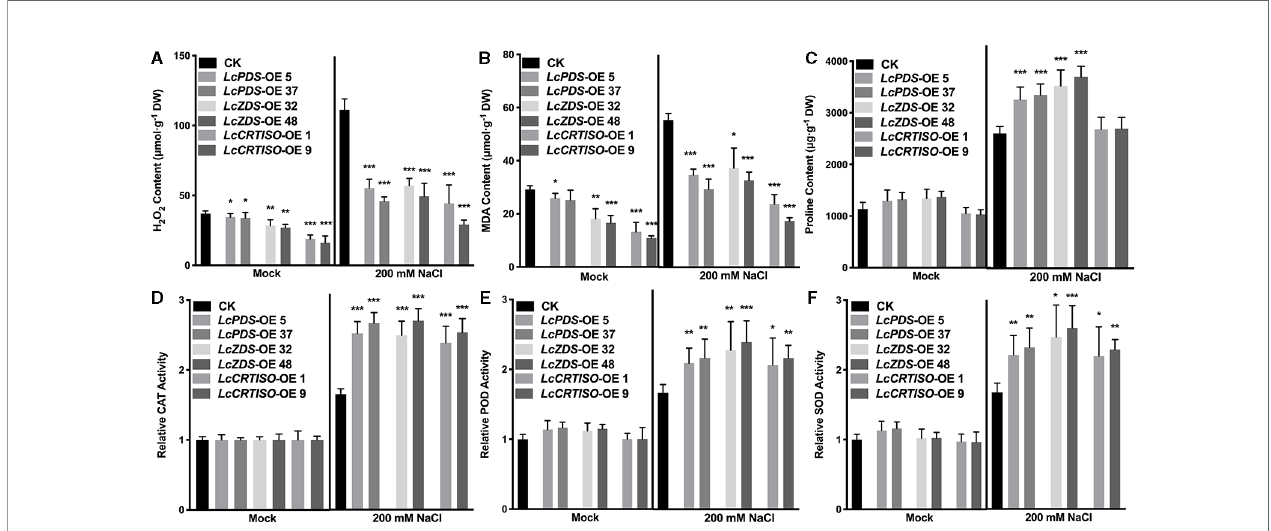
FIGURE 3 | Antioxidative components in LcPDS , LcZDS , and LcCRTISO over-expressing tobacco lines were analyzed. The contents of (A) H 2 O 2 , (B) malonaldehyde (MDA), and (C) proline were assayed, and activities of (D) catalase (CAT), (E) peroxidase (POD), and (F) superoxide dismutase (SOD) were analyzed. Data were obtained from three independent experiments and ANOVAs was performed. The results were presented as means ± SD. P values of < 0.05 (*), < 0.01 (**), and < 0.001 (***) were considered to be signi fi cant statistically.